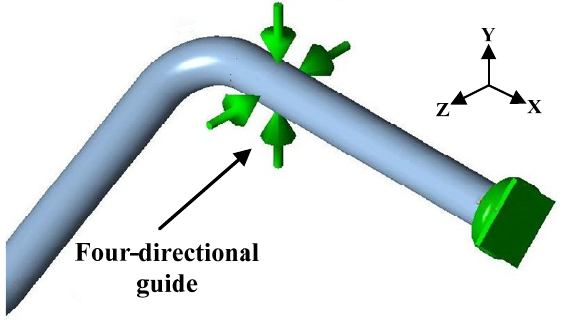
Figure 8. The model of four-directional guide.